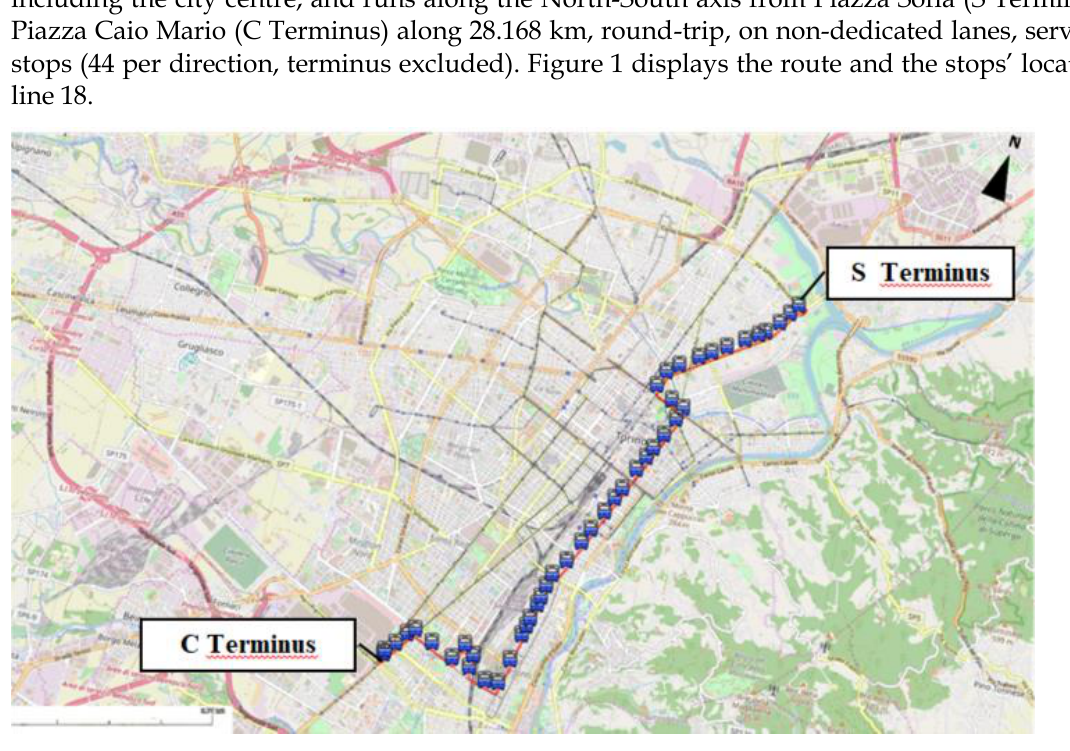
Figure 1. Line 18 route and stop’s